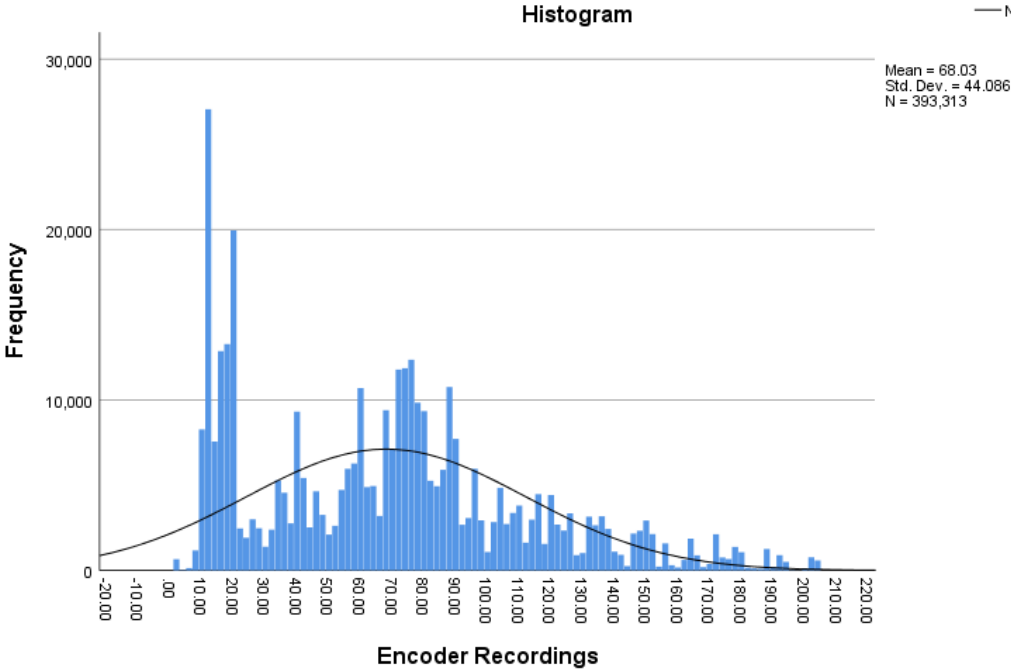
Figure 6. Histogram of encoder recordings for entire dataset.